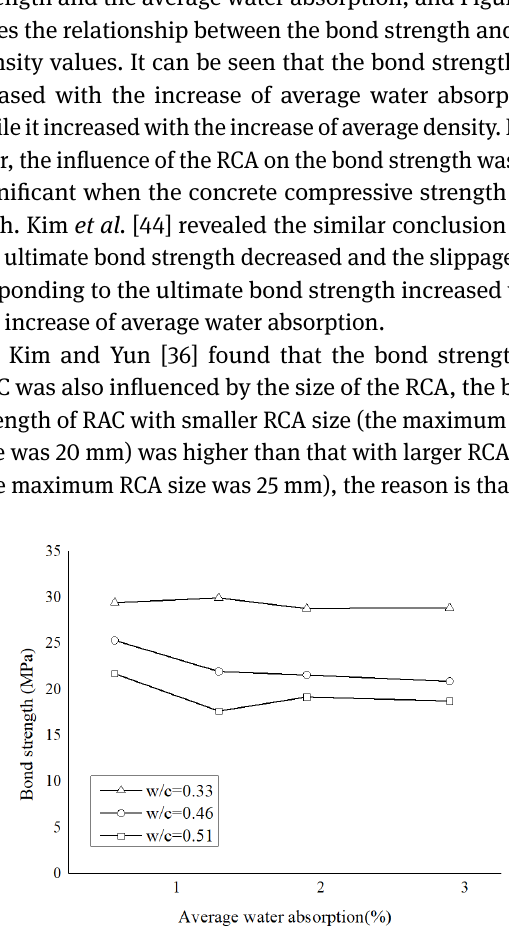
Figure 9: Relationship between bond strength and average water absorption.